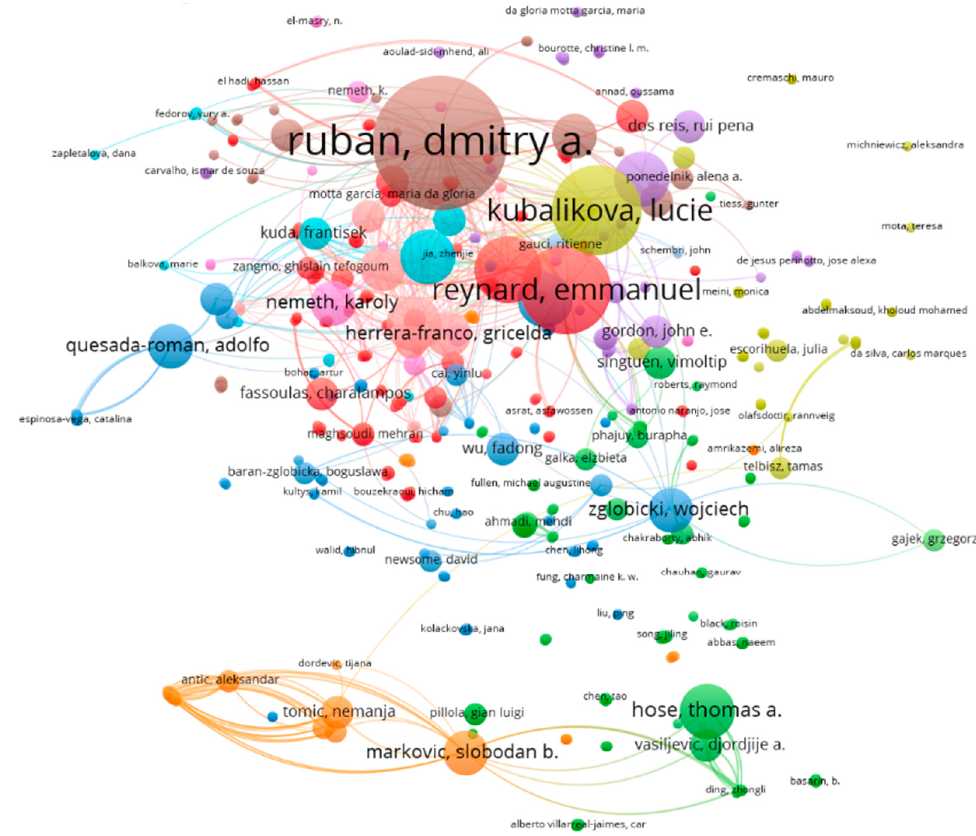
Figure 5. Most-productive authors dealing with methods and resources promoting geoconservation and and geotourism.